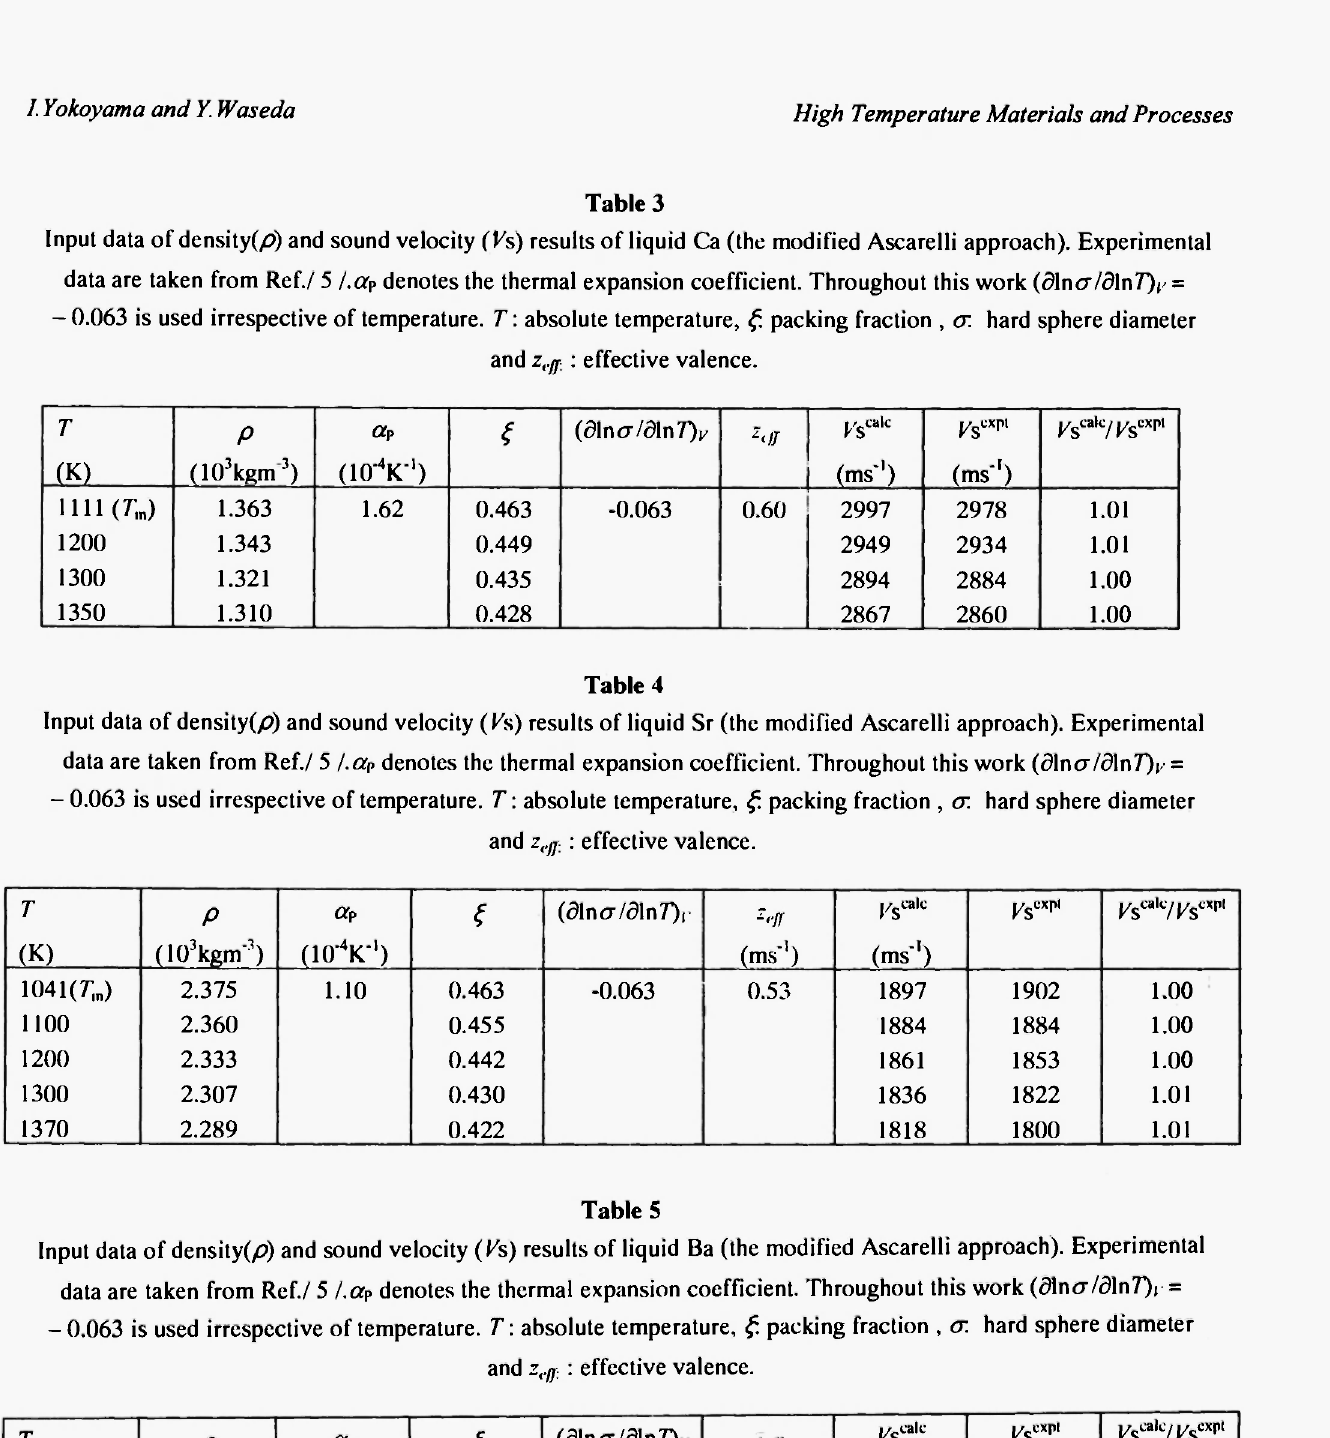
Input data of density(/?) and sound velocity (Ks) results of liquid Ba (the modified Ascarelli approach). Experimental data are taken from Ref./ 5 /.a P denotes the thermal expansion coefficient. Throughout this work (δίησ/öln7)i = - 0.063 is used irrespective of temperature. Τ : absolute temperature, ξ. packing fraction , σ. hard sphere diameter and ζ,.β : effective